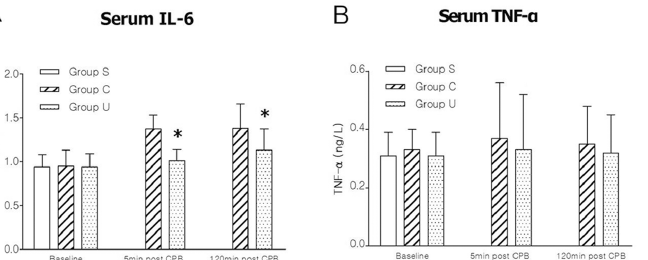
Fig 1. Results of plasma markers of inflammation in the three groups. (A) serum IL-6, interleukin-6; (B) serum TNF- α , tumor necrosis factor- α . Data are presented as mean ± SD, n = 6, * P < 0.05 versus Group C. For graphs pooled estimates for pairwise comparisons derived from Analysis of Covariance with adjustment for baseline serum IL-6 at 0.94 ± 0.13 μ g/L, serum TNF- α 0.32 ± 0.05ng/L, were as follows: IL-6; 5min post CPB (T2): Group C, 1.37 ± 0.16 μ g/L, Group U, 1.01 ± 0.13 μ g/L. Test for overall treatment effect p = 0.021. 120min post CPB(T3): Group C, 1.38 ± 0.28 μ g/L, Group U, 1.13 ± 0.24 μ g/L. Test for overall treatment effect P = 0.001. TNF- α ; 5min post CPB(T2): Group C, 0.37 ± 0.19 ng/L, Group U, 0.33 ± 0.19ng/L. Test for overall treatment effect P = 0.075. 120min post CPB(T3): Group C, 0.35 ± 0.13 ng/L, Group U, 0.32 ± 0.13 ng/L. Test for overall treatment effect P = 0.088.